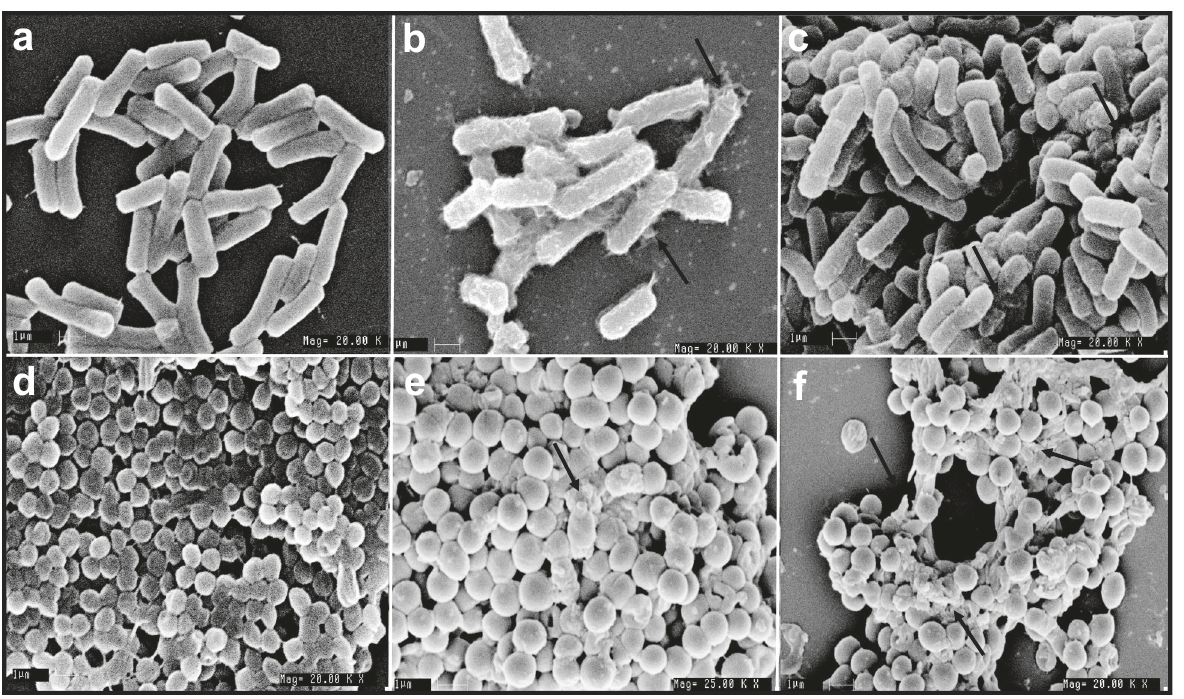
Fig. 5 Scanning electron micrographs (SEM) of B. cereus and M. luteus treated with the peptides. Upper panels — SEM micrographs of B. cereus : a Control, no peptide; b HSEP2-treated; c HSEP3-treated. Lower panels — SEM micrographs of M. luteus : d Control, no peptide; e HSEP2- treated (at ×25 magni fi cation, while all others are at ×20); f HSEP3-treated. Note that for all images the scale bar denotes 1 μ